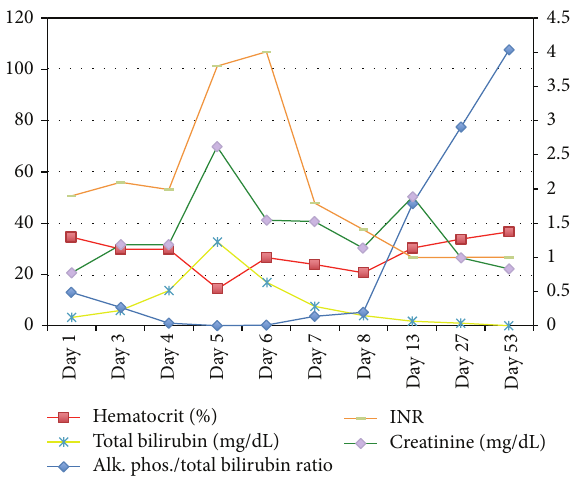
Figure 1: Trend of lab values during the acute setting of liver failure and posttransplant up to a 2-month follow-up.